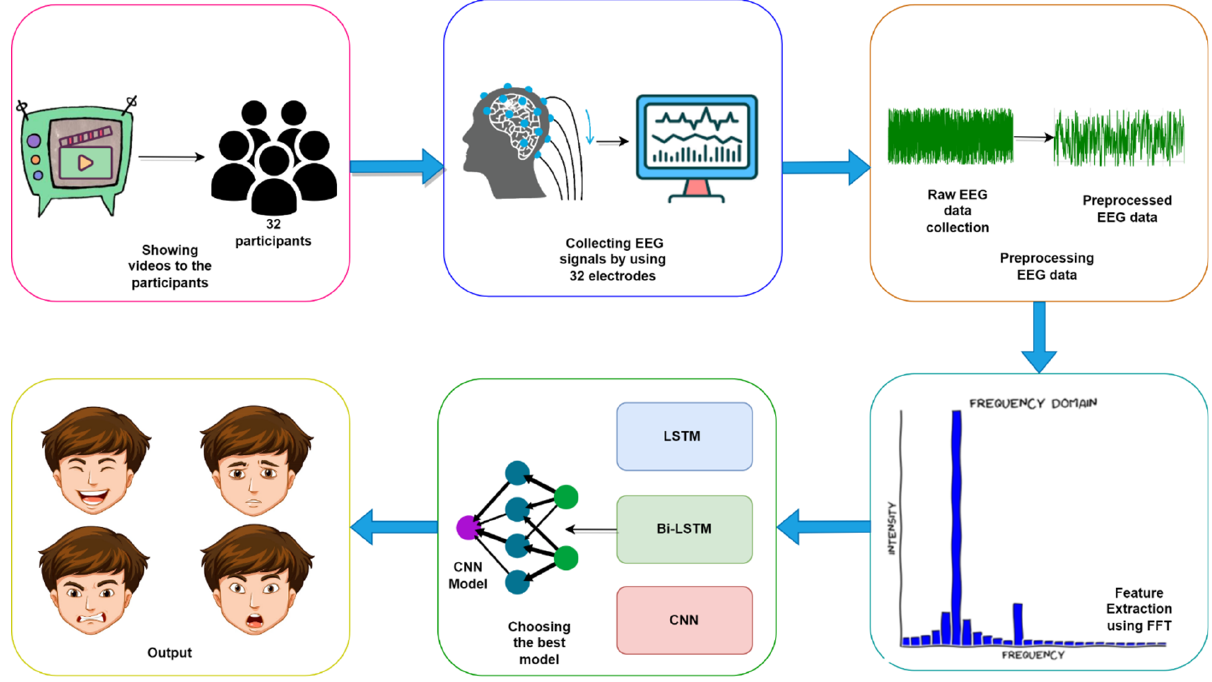
Figure 1. Complete workflow of the proposed emotion recognition pipeline from DEAP dataset.